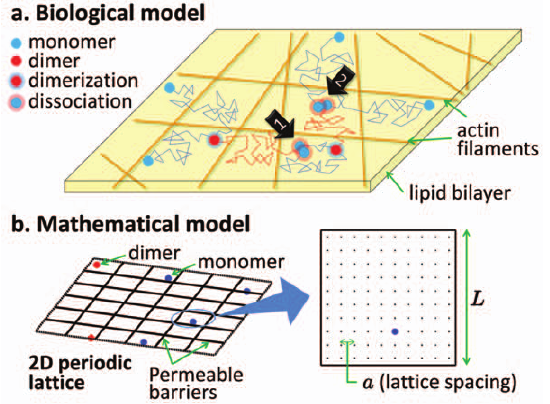
Figure 1. The models of reversible dimer formation in the compartmentalized plasma membrane. a. Schematic illustration of the compartmentalized view of the plasma membrane according to the membrane skeleton fence model [13], and the kinetics of reversible dimer formation as described in the text. The thin lines correspond to the random paths traced by the molecules while diffusing in the membrane. b. illustration of the lattice-based model of diffusion and reaction in two-dimensions (2D) (see the Methods section for details, and Video S1 for an animation based on this model).